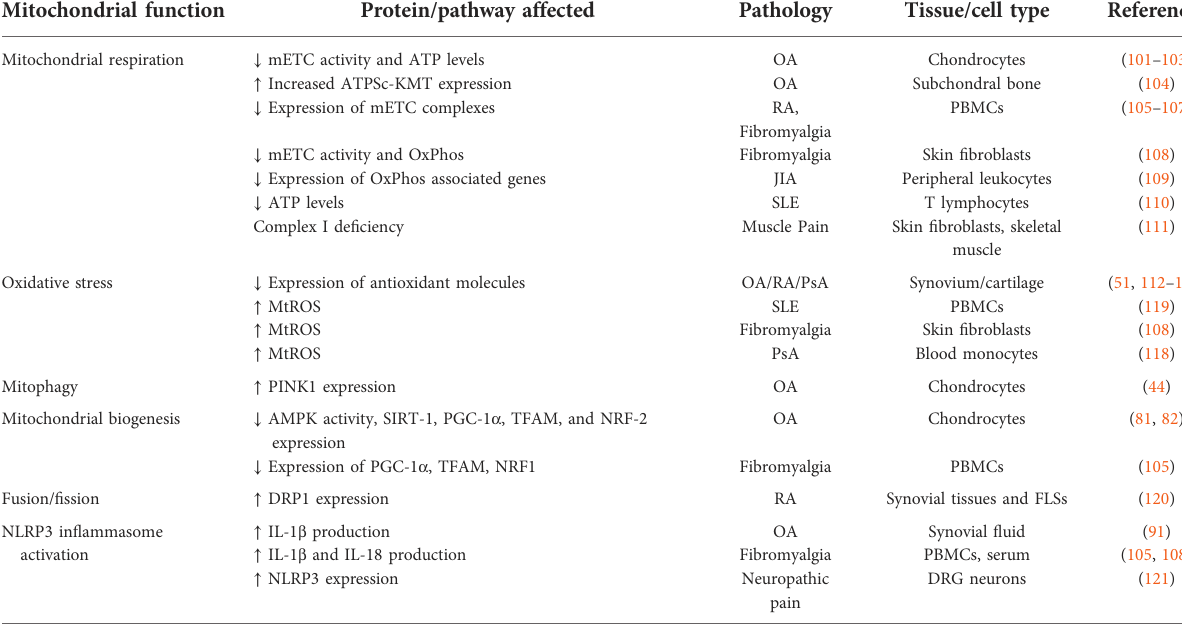
TABLE 2 Overview of mitochondrial dysfunction in patients with rheumatic